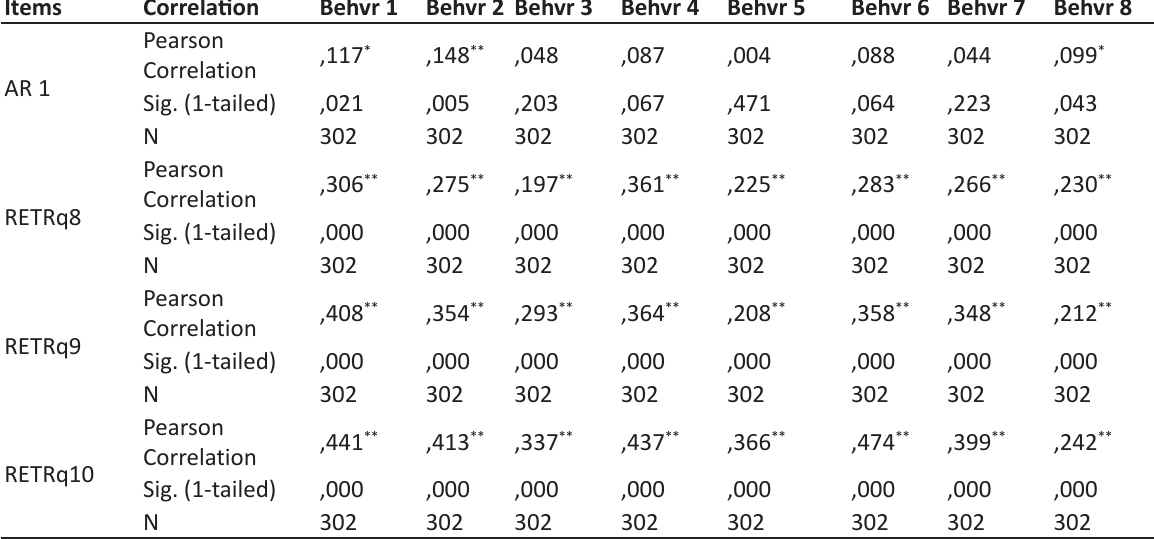
Table 8. Correlations between the CT behavior and the PE-ST attractiveness of the profession repercussions